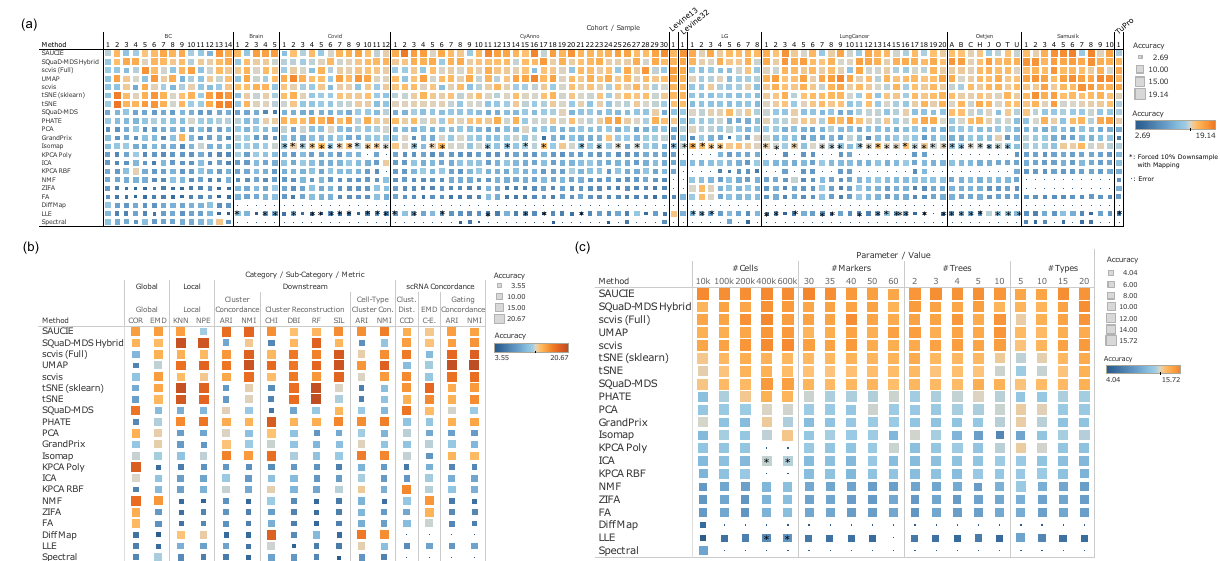
Fig.3|DetailedresultsontheaccuracyperformancesoftheDRmethods.a The accuracy performances of the DR methods on all real CyTOF datasets, grouped by the 11 cohorts. Orange color indicates better performance, while blue color indi- cates worse performance. All submetrics of the accuracy criterion were averaged. “ * ” indicates thatforced 10% downsampling was performed for training in the case that the methods aborted because of sample size. “ scvis ” is always performed on 10% down-samples per authors ’ recommendation. Small blue dot indicates error. b The accuracy performances of the DR methods for each accuracy